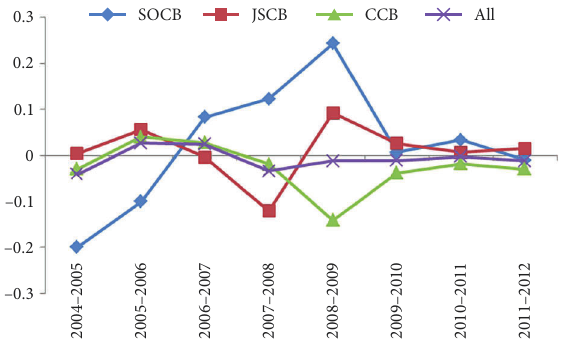
Figure 5. ECG change: 2004–2012